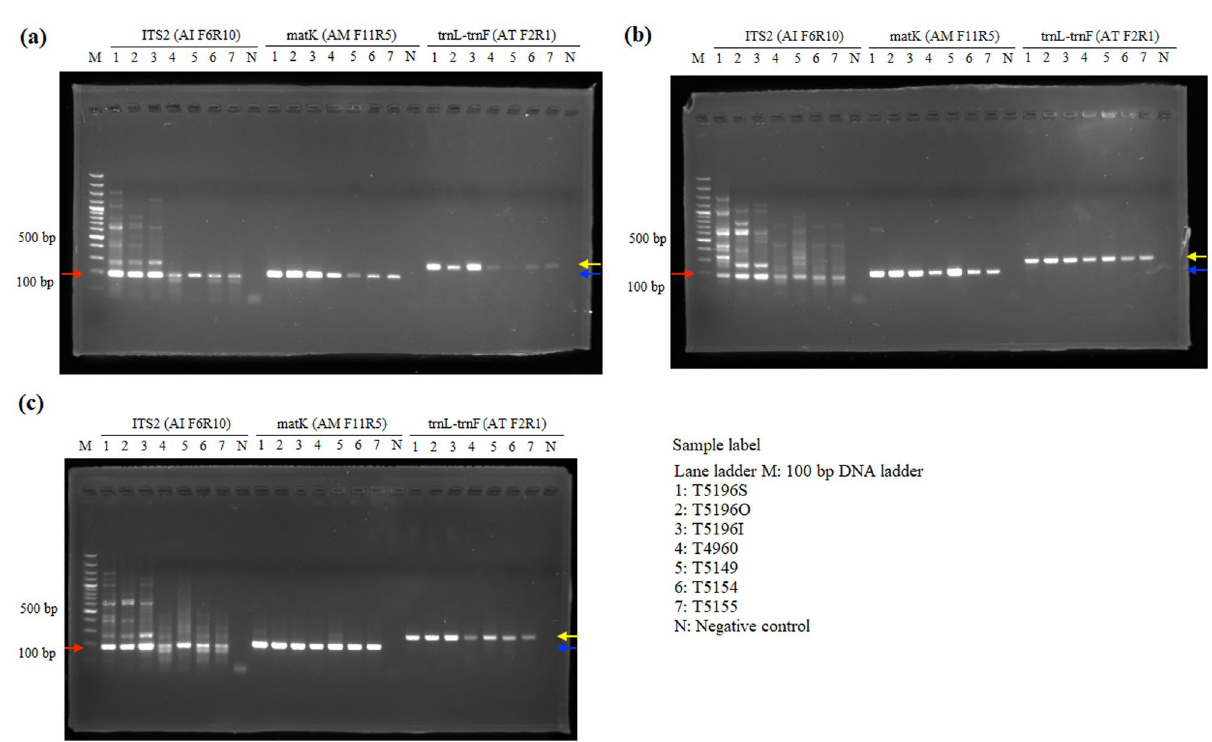
Figure 2. Gel electrophoresis of PCR amplification results of Aquilaria authentic wood samples using different extraction methods, ( a ) SDS-based method, ( b ) QIAGEN method, and ( c ) CCDB method. Red arrows indicate the amplicons of ITS2 (181 bp). Blue arrows indicate the amplicons of matK (209 bp). Yellow arrows indicate the amplicons of trnL - trnF (280